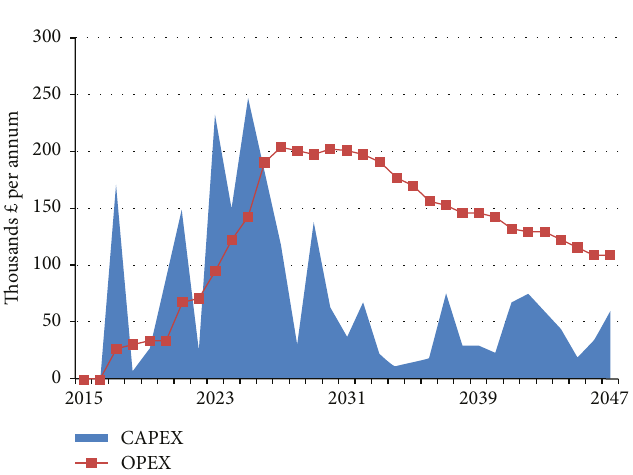
Figure 19: CAPEX and OPEX; DECC2, 2015 – 2047.